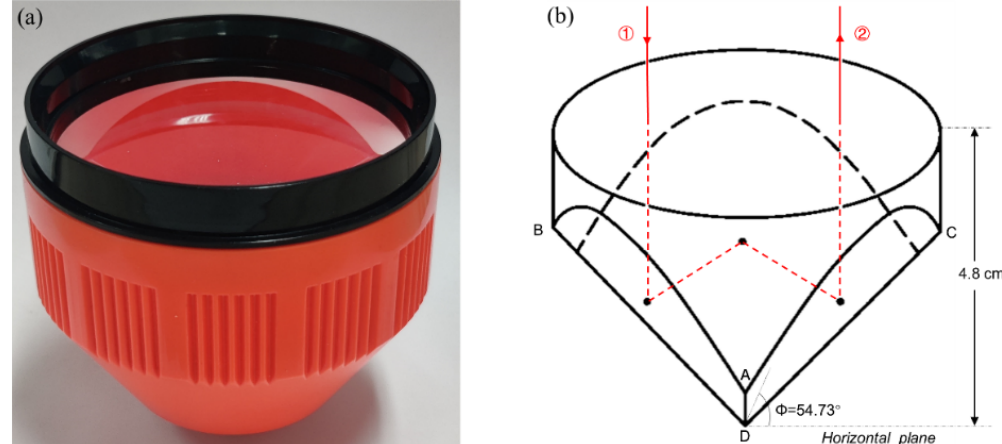
Figure A1. (a) CCR head used for calibration of ICESat-2 ATL03 data and (b) parameters of the lens system and optical path of a total- reflecting